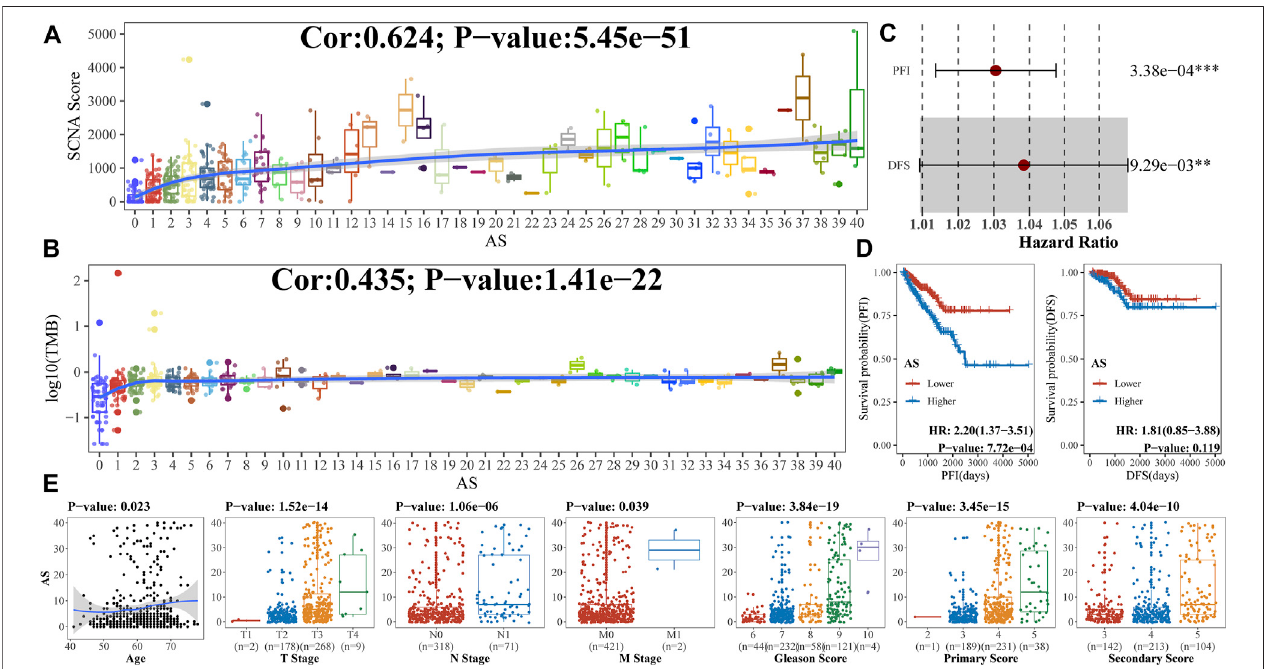
FIGURE 3 | Association of aneuploidy with clinical characteristics (A, B) . As revealed in previous study, both SCNA score and TMB were special genomic characteristics and important to carcinoma; we utilized Spearman correlation analysis to uncover relationships between aneuploidy and (A) SCNA score or (B) log10 (TMB). (C) UnivariableCoxanalysiswasappliedtocon fi rmprognosticimplicationsofaneuploidy; (D) Kaplan – MeieranalysiswasalsousedbasedonmedianvalueofAS; (E) Spearman correlation coef fi cients (for age), Wilcoxon rank-sum test (for T stage, N stage, and M stage), and Kruskal – Wallis rank-sum test (for Gleason score) were utilized to explore relationships between aneuploidy and clinical characteristics.